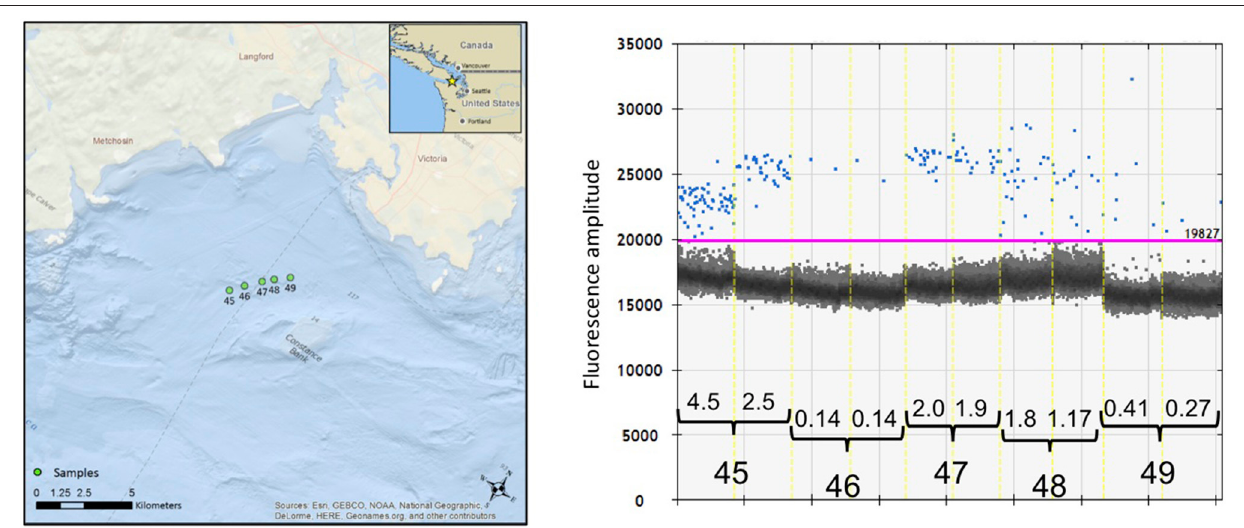
FIGURE 6 | The location of samples collected during encounter #e11 with killer whales on August 12, 2015 and the result of the ddPCR quantification of eDNA from serial samples. (Left) Location of five serial samples (#s45 to #s49) as determined by the GPS of the Lagrangian drifter deployed initially 200m after the passage of the whales. (Right) Visualization and analysis of five serial samples using the software QuantiSoft. The estimated copies/ µ L of eDNA from the killer whales measured by the number of target-positive droplets (shown in blue) above the baseline of target-negative droplets (shown as the dark cloud). The purple line shows the upper threshold of the target-negative droplets calculated from the negative controls. The black bars indicate the pairs of replicate samples, separated by the dashed yellow line. The calculated copies/ µ L are shown above the black brackets for each of the replicate samples. Two of the serial samples was re-amplified and sequenced to confirm the species (see